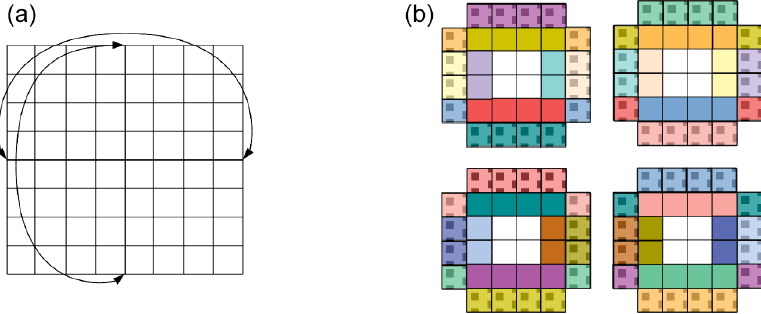
Figure 4. (a) A domain of 64 grid points. It is assumed double-periodic for illustration purposes. (b) The domain decomposed in four subdomains. Grid points with the same colour are duplicated, with halos depicted with